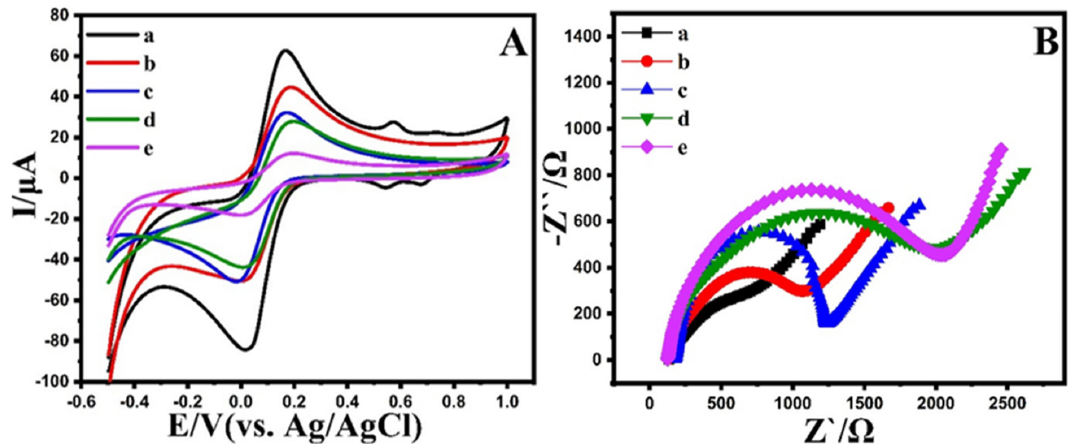
Figure 4. ( A ) CVs and ( B ) EIS of Co/Ni@MOF/SPE (a), BSPE (b), MIP ‐ Co/Ni@MOF/SPE after removal (c), MIP ‐ Co/Ni@MOF/SPE after removal (c), MIP-Co/Ni@MOF/SPE after rebinding (d), and NIP-Co/Ni@MOF/SPE (e) in rebinding (d), and NIP ‐ Co/Ni@MOF/SPE (e) in the presence of 5.0 mM [Fe(CN) 6 ] 3 ‐ /4 ‐ containing 0.1M KCl. Condition CV was recorded at a scan rate of 50.0 mV/s, and EIS was recorded at a potential of 0.1 V and frequency of 0.1 to 100 kHz.